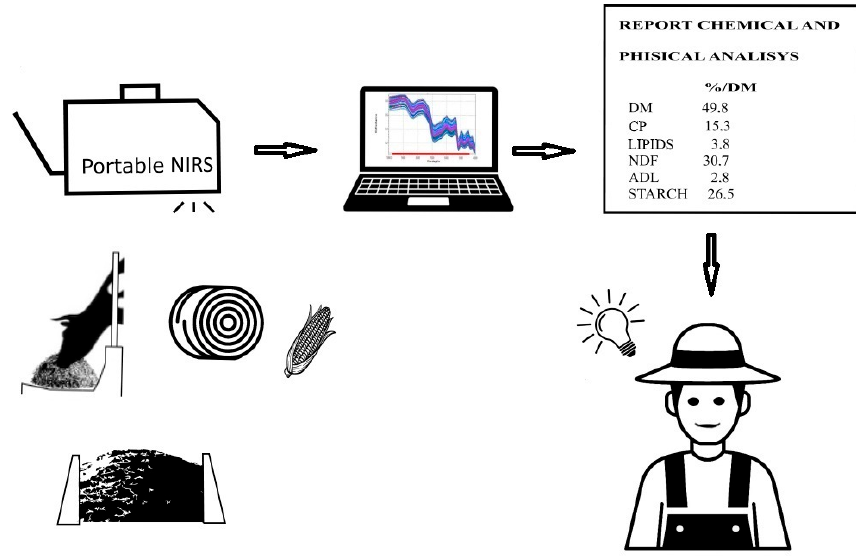
Figure 2. Use of portable NIRS tool by a breeder on the farm to increase precision feeding .